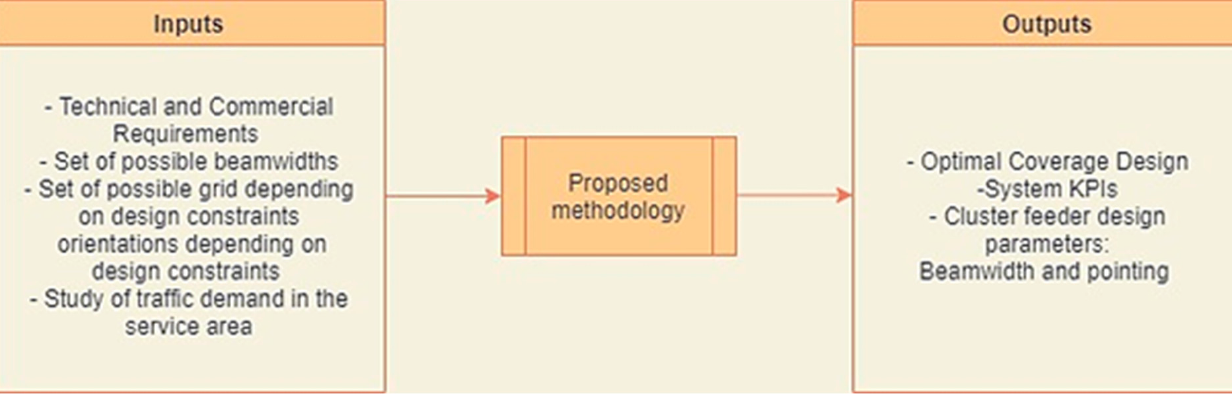
Figure 8. Inputs and outputs obtained with the proposed methodology.